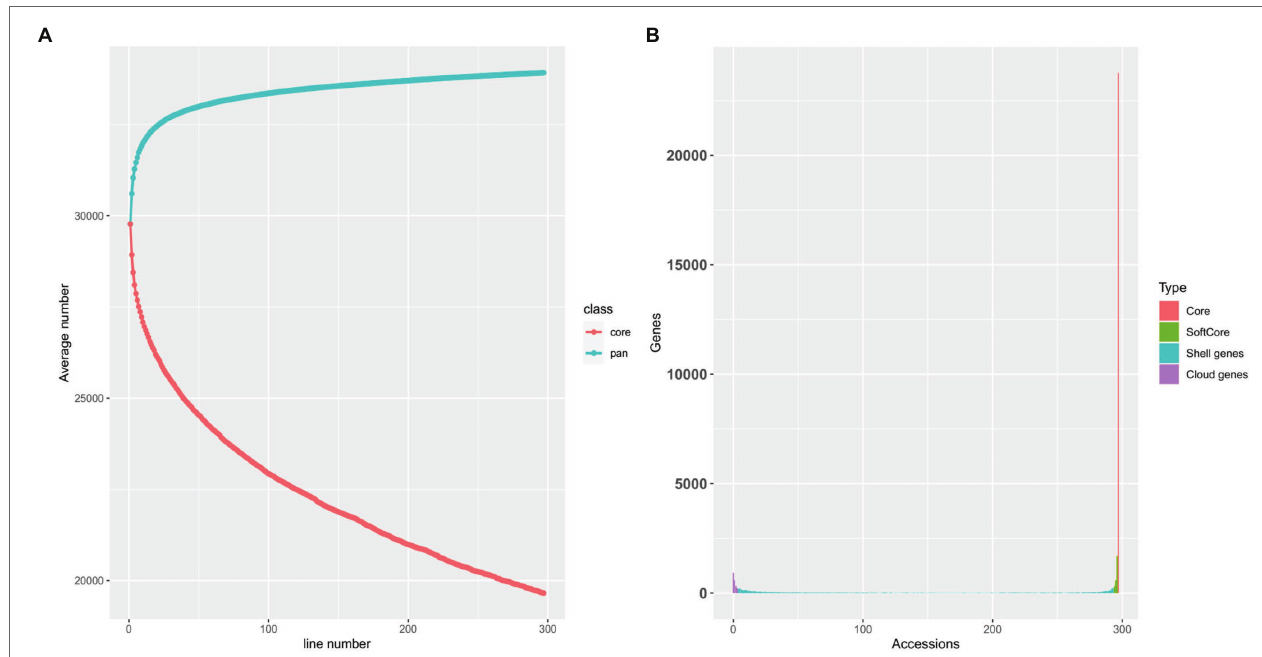
FIGURE 1 | (A) The pan-genome modeling shows no new gene increases when the number of accession genomes is greater than 200, indicating that selected individuals were sufficient to capture the majority of presence/absence variations (PAVs) within melon. Upper and lower lines represent the total gene number of pan-genome and core-genome number, respectively. (B) Composition of the melon